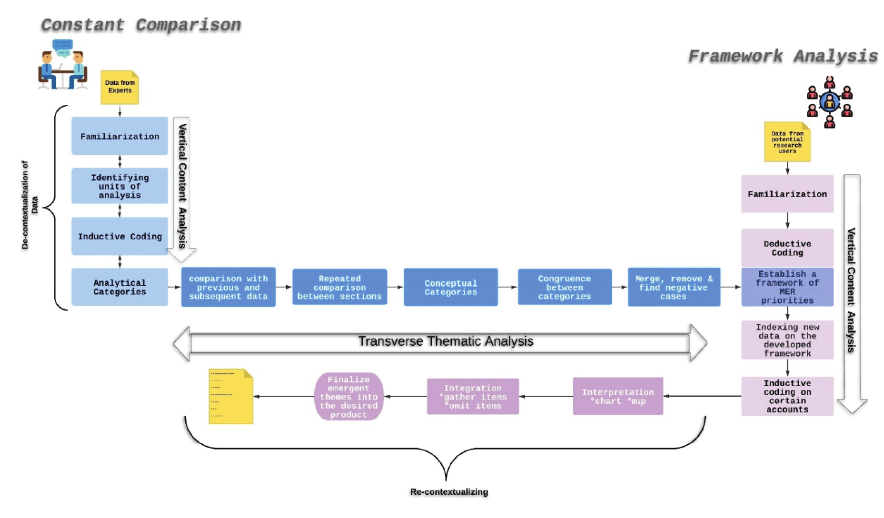
Figure 1 : Overview of the Analysis Process – Vertical content analysis of both data sources and transverse thematic analysis (constant comparison for interview data and framework analysis for focus group